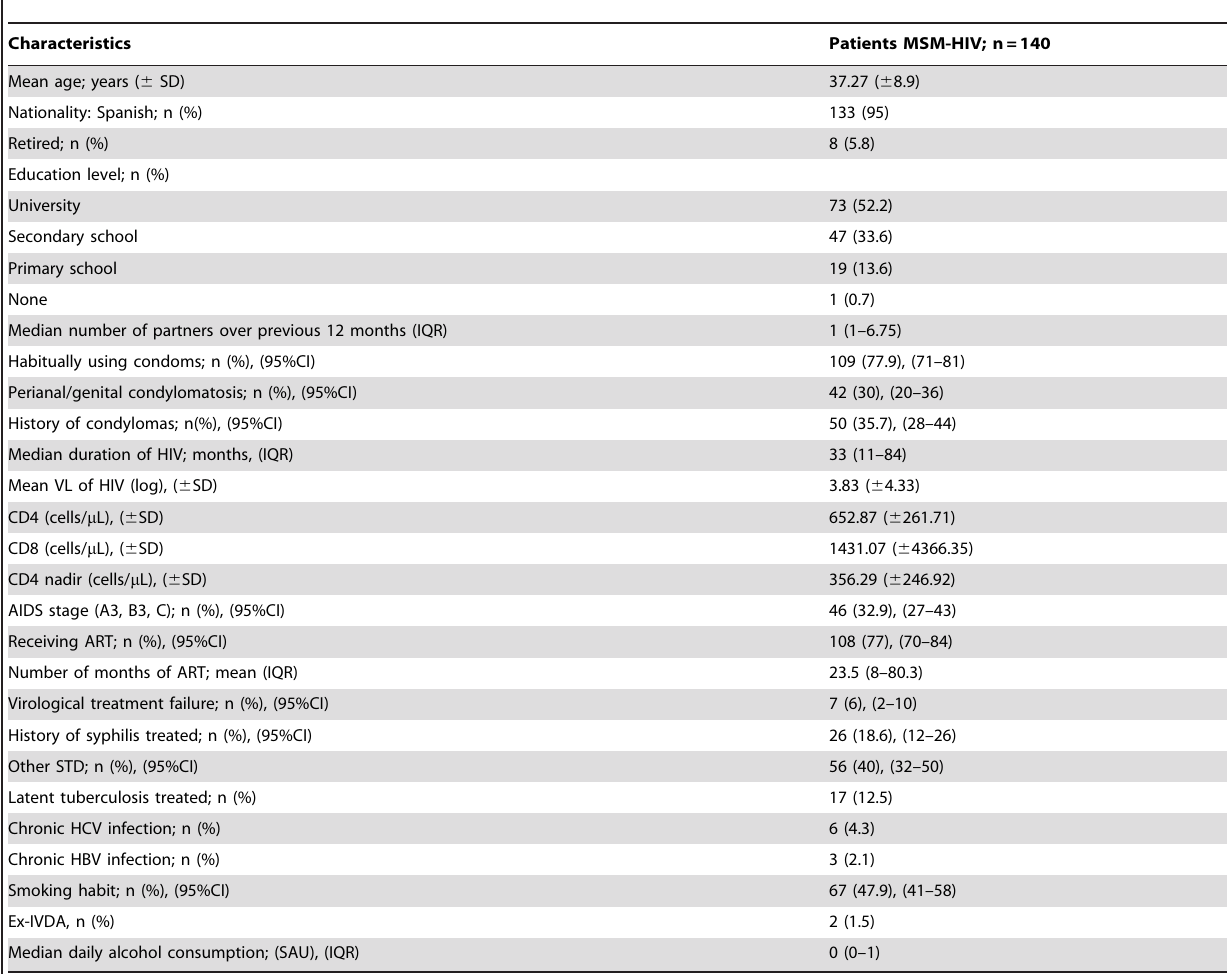
Table 1. General description of the patient cohort, and results of the PCR of HPV, cytology and anoscopy.